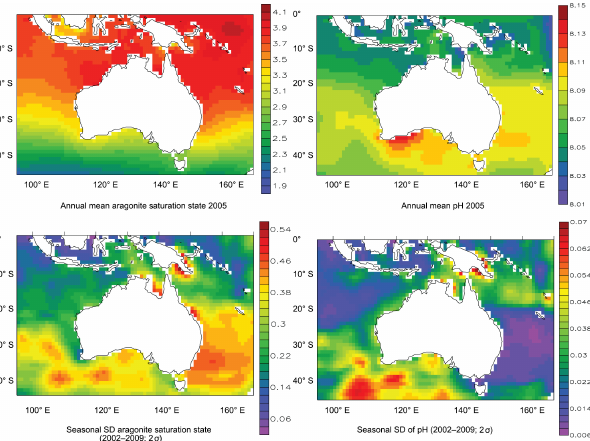
Figure 5. Upper: the reconstructed annual mean aragonite satura- tion state and pH for the period 2000–2009. Lower: the seasonal variability given by 2 times the standard deviation (2 σ) of the sea- sonal variability in aragonite saturation state and pH from the period